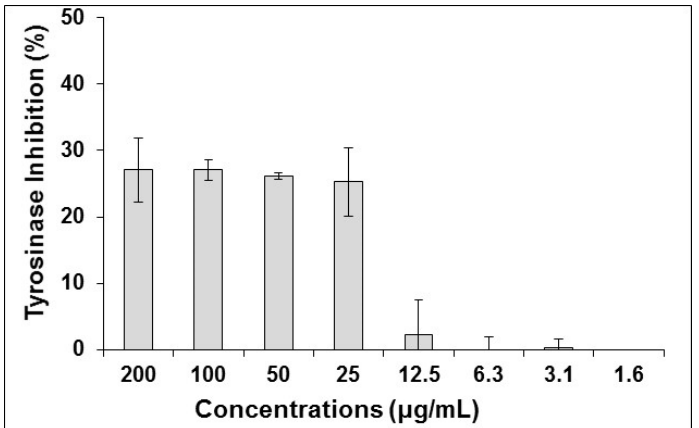
Figure 1. The inhibitory effect of S. perfoliata on mushroom tyrosinase at different treatment concentrations. Data is represented as are means ± SD (n = 3).